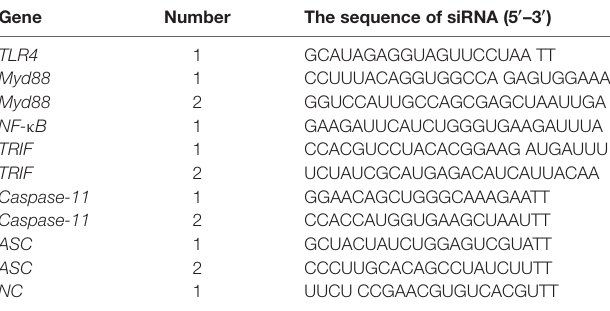
TABLE 2 | The sequences of small interfering RNAs (siRNAs) used in the present